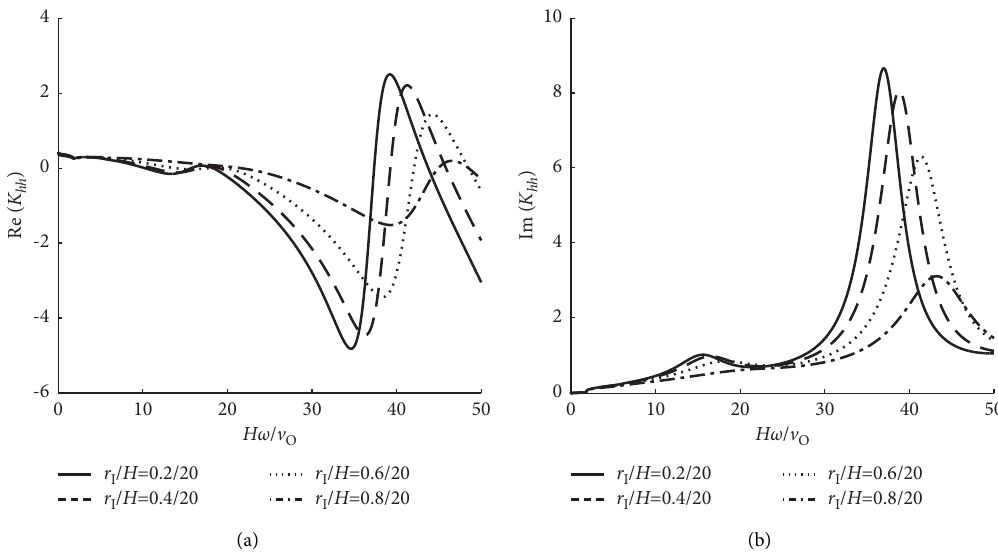
Figure 17: The horizontal dynamic impedance curves of pipe pile with different inner radii. (a) Real part of horizontal dynamic impedance. (b) Imaginary part of horizontal dynamic impedance.